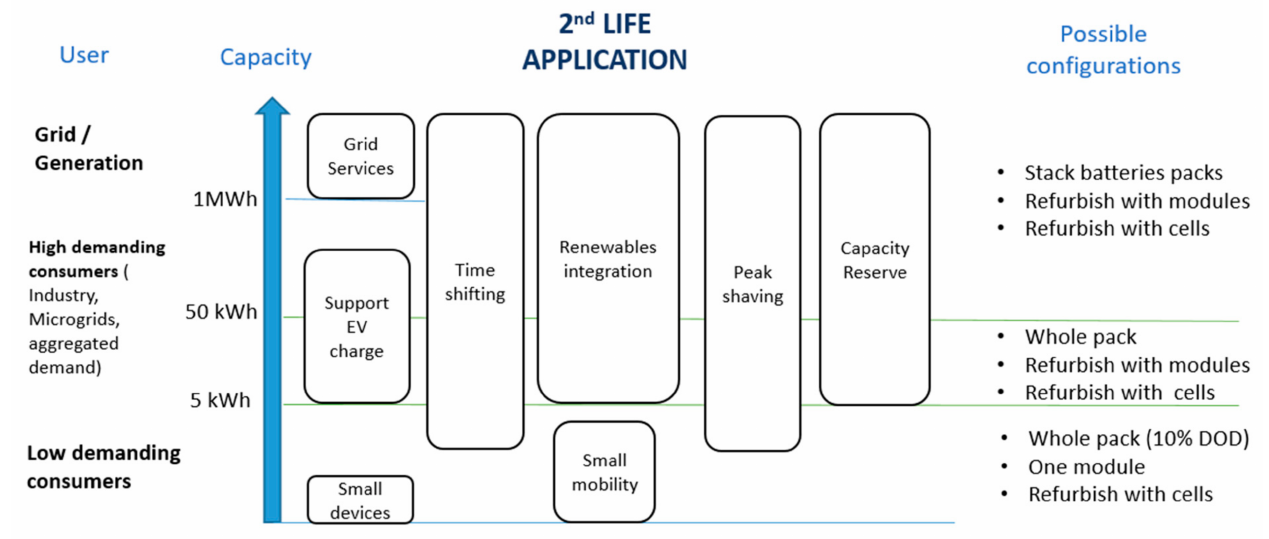
Figure 2. Possible configurations and applications depending on the desire capacity.